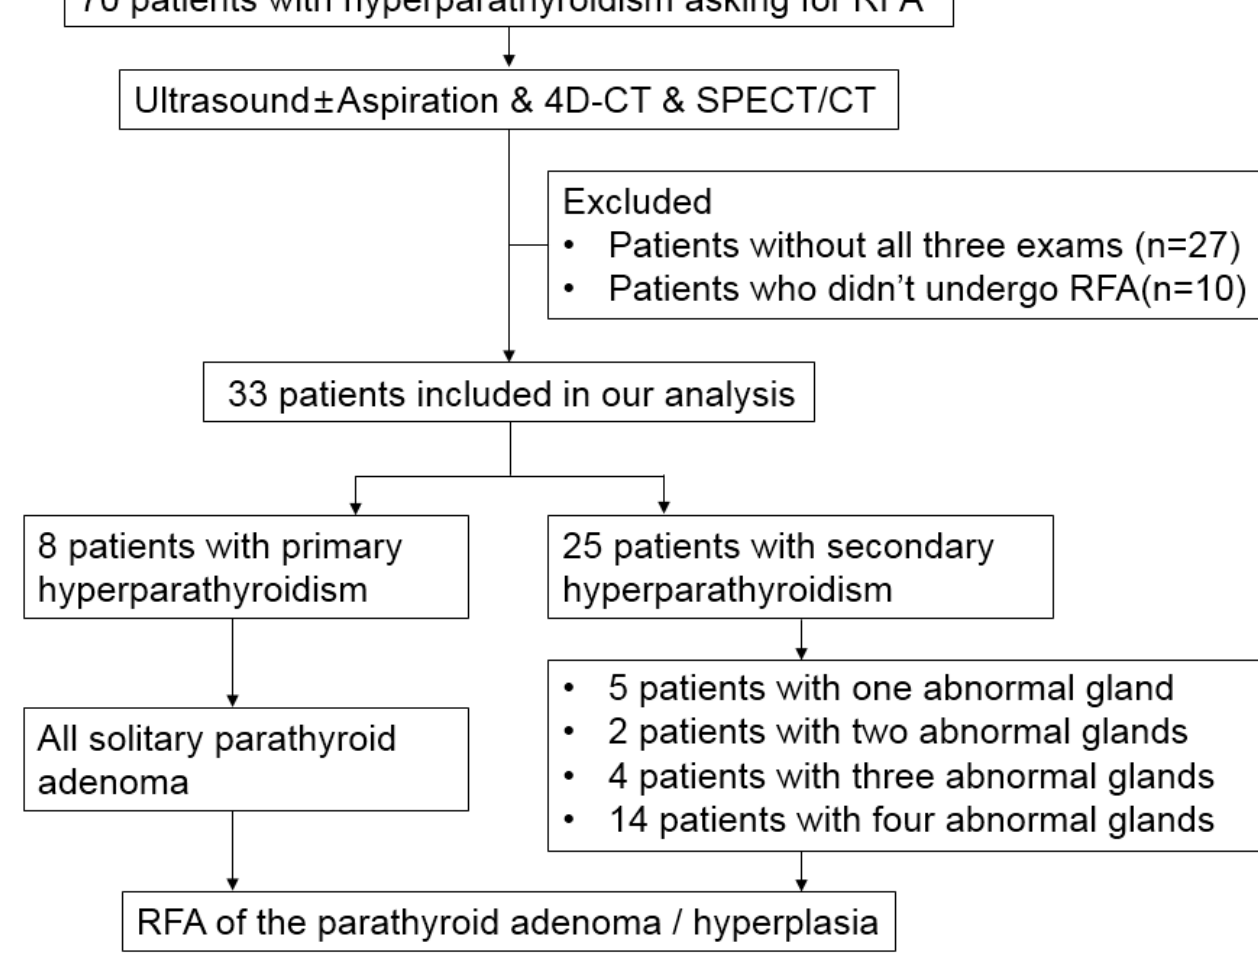
Figure 1. The study flowchart of patient selection process with inclusion and exclusion criteria. RFA = radiofrequency ablation. 4D-CT = four-dimensional CT. SPECT/CT = technetium 99m–sestamibi single-photon-emission-computed tomography/computed tomography.